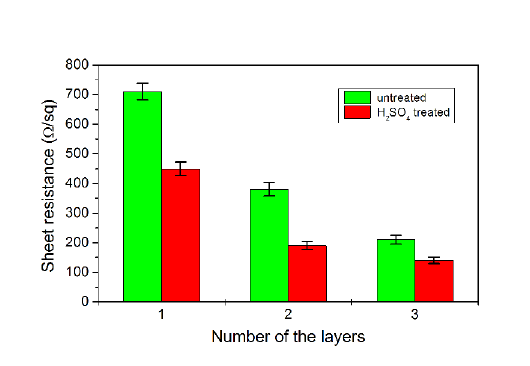
Figure 6. Sheet resistance of the pristine and sulfuric acid treated DMSO-doped PEDOT:PSS films. Each column of the histogram is plotted with error bar representing the standard